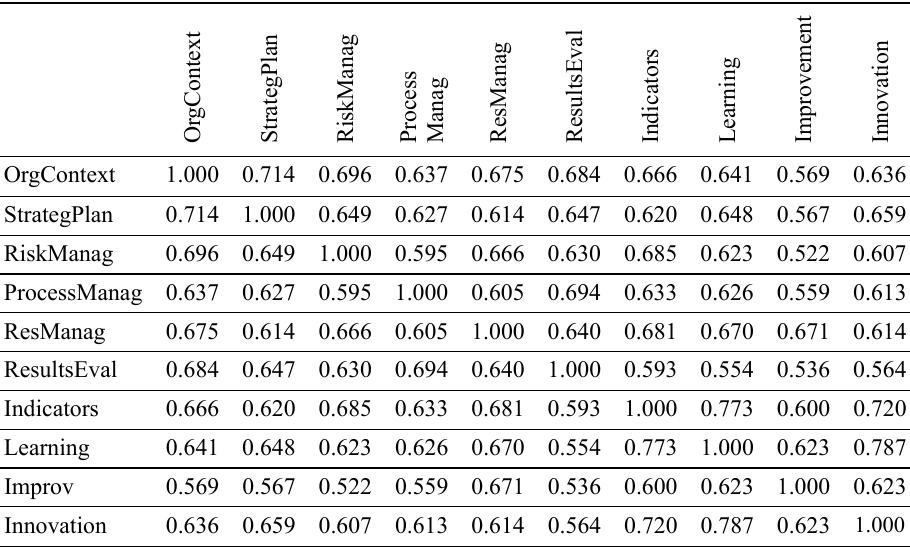
Table 3. Inter-item correlation